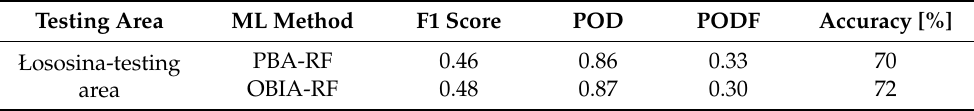
Figure 7. Training and testing area were superimposed on the random forest (RF) classification results for OBIA ( a ) and PBA ( b ) according to strategy 2. Table 6. Accuracy assessment for training and testing strategy 2 (Ro˙zn ó w Lake